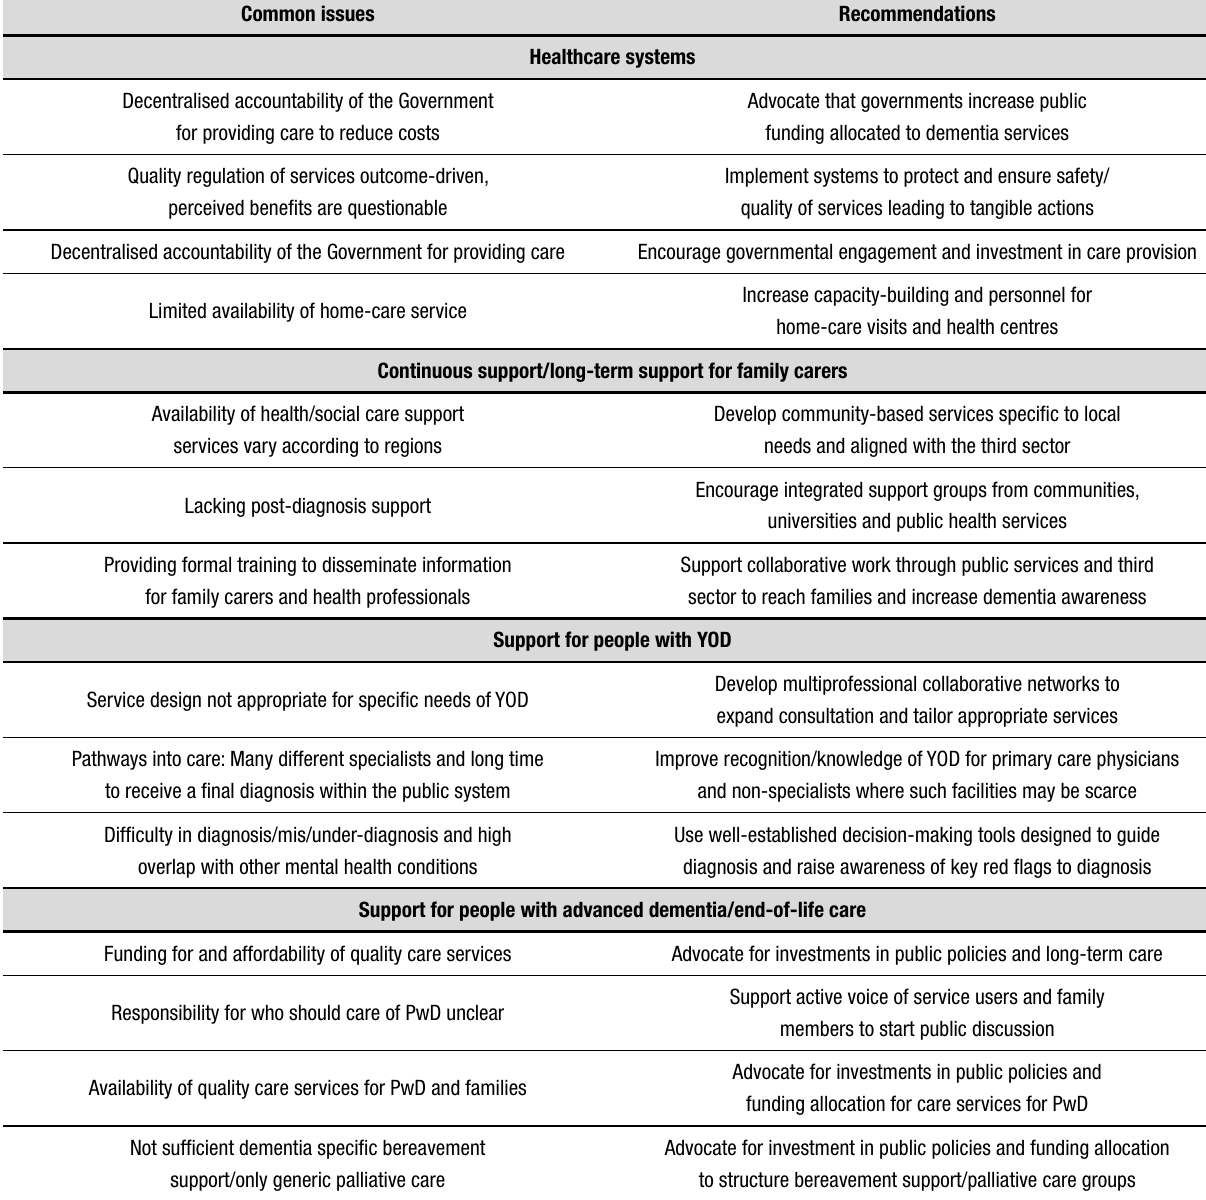
Table 1. Comparison of dementia care challenges and recommendations (Brazil and